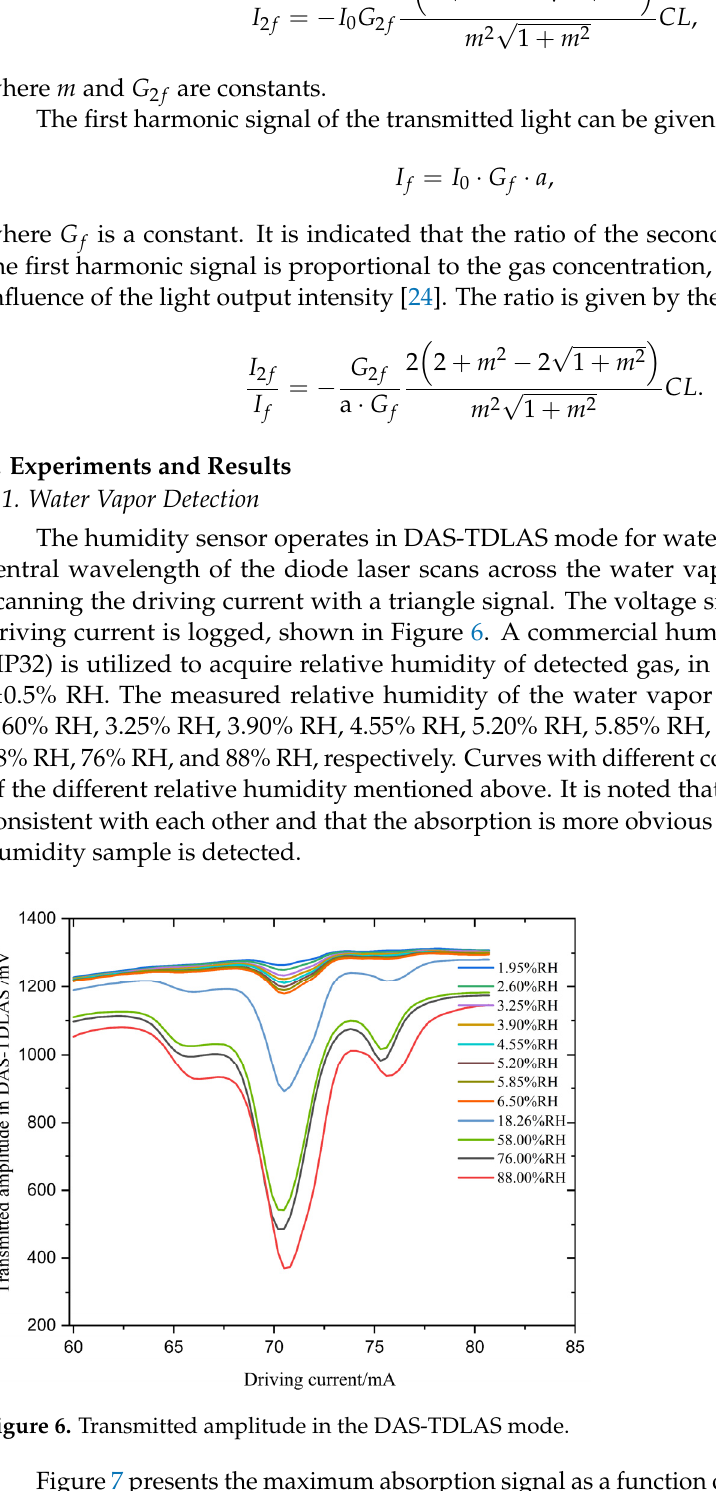
Figure 7. Relative humidity measured in DAS-TDLAS. 3.2. Heavy Oxygen Water Vapor Detection The performance of the proposed humidity sensor for heavy oxygen water vapor detection is evaluated in the WMS-TDLAS mode. The driving current scans so that the central wavelength scans across the absorption line. A triangle signal and a sinusoidal signal modulate the driving current simultaneously. The frequency of the triangle signal is 100 Hz, and the frequency of the sinusoidal signal is 10 kHz. The modulation depth is optimized. The second harmonic signals measured at different relative humidity are shown in Figure 8. The same humidity sensor (Rotronic, HP32) used for water vapor de- tection is used to acquire relative humidity. The measured relative humidity of the heavy oxygen water vapor samples is 3.4% RH, 6.8% RH, 10.2% RH, 13.6% RH, and 17% RH, respectively. The profiles are consistent with each other and reach their maximums at the center of the absorption lines.